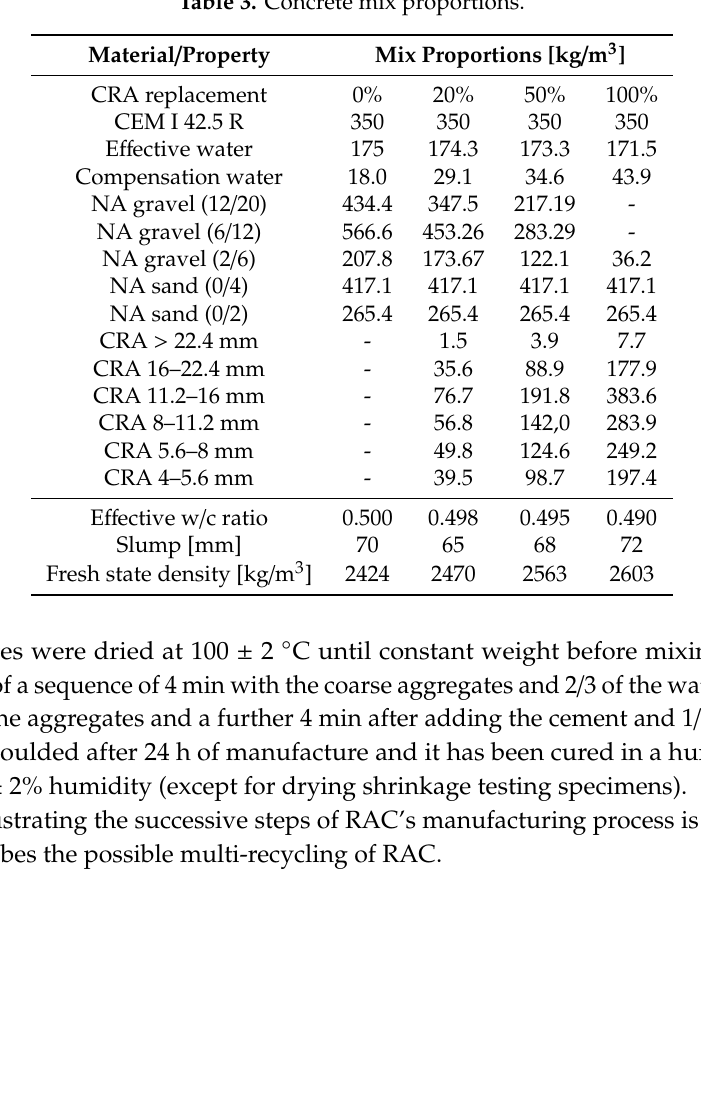
Table 3. Concrete mix